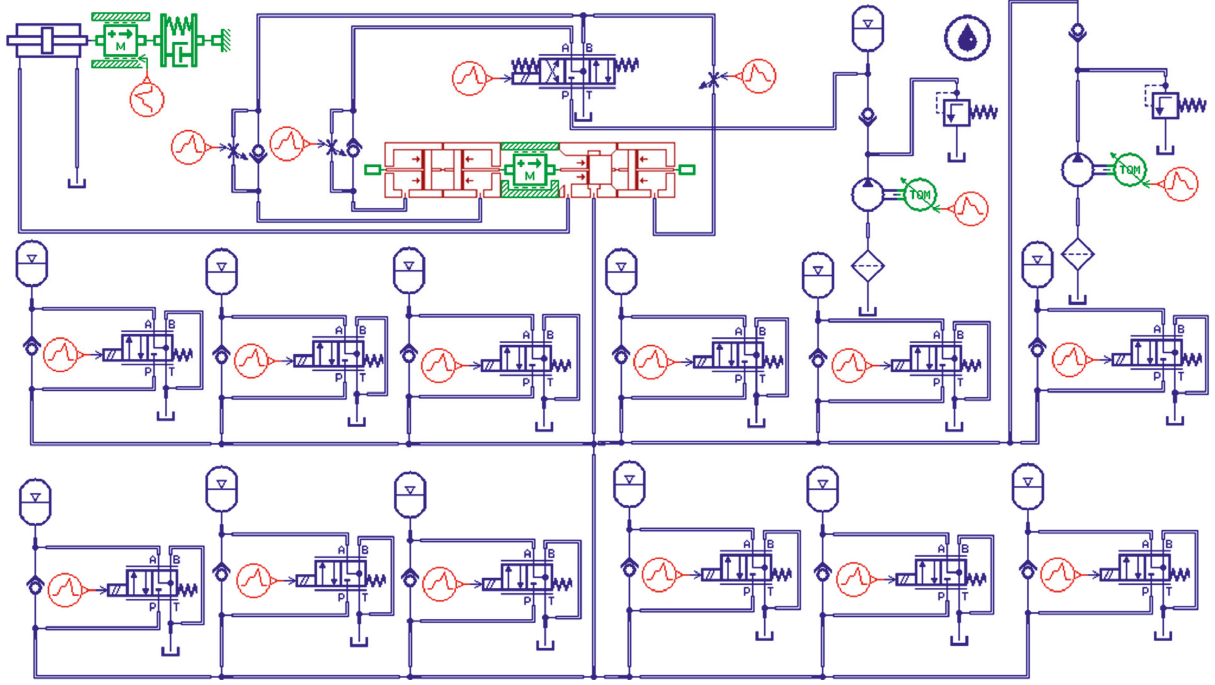
Figure 4: AMESim model of impact loading system. Table 3: AMESim parameter